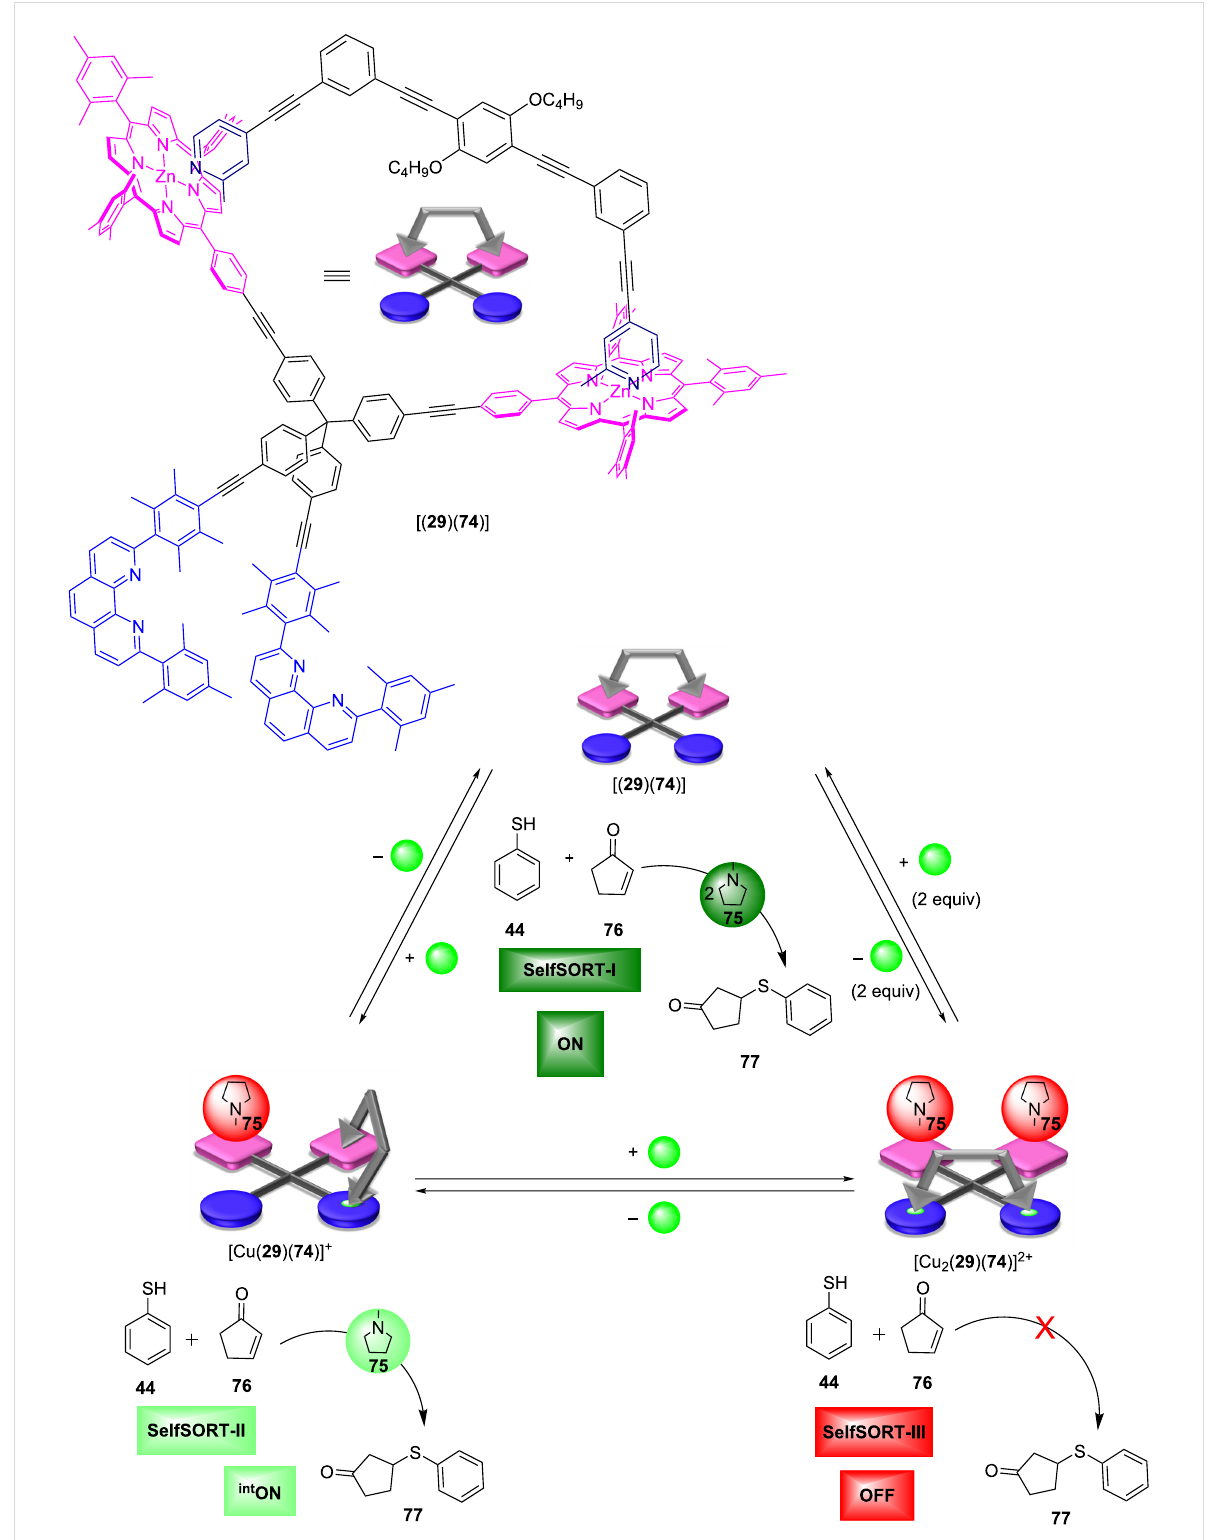
Figure 20: A biped walking along a tetrahedral track and unfolding its catalytic action. Adapted with permission from https://pubs.acs.org/doi/10.1021/ acs.inorgchem.7b02703 [75]. Copyright (2018) American Chemical Society. Further permissions related to the material excerpted should be directed to the